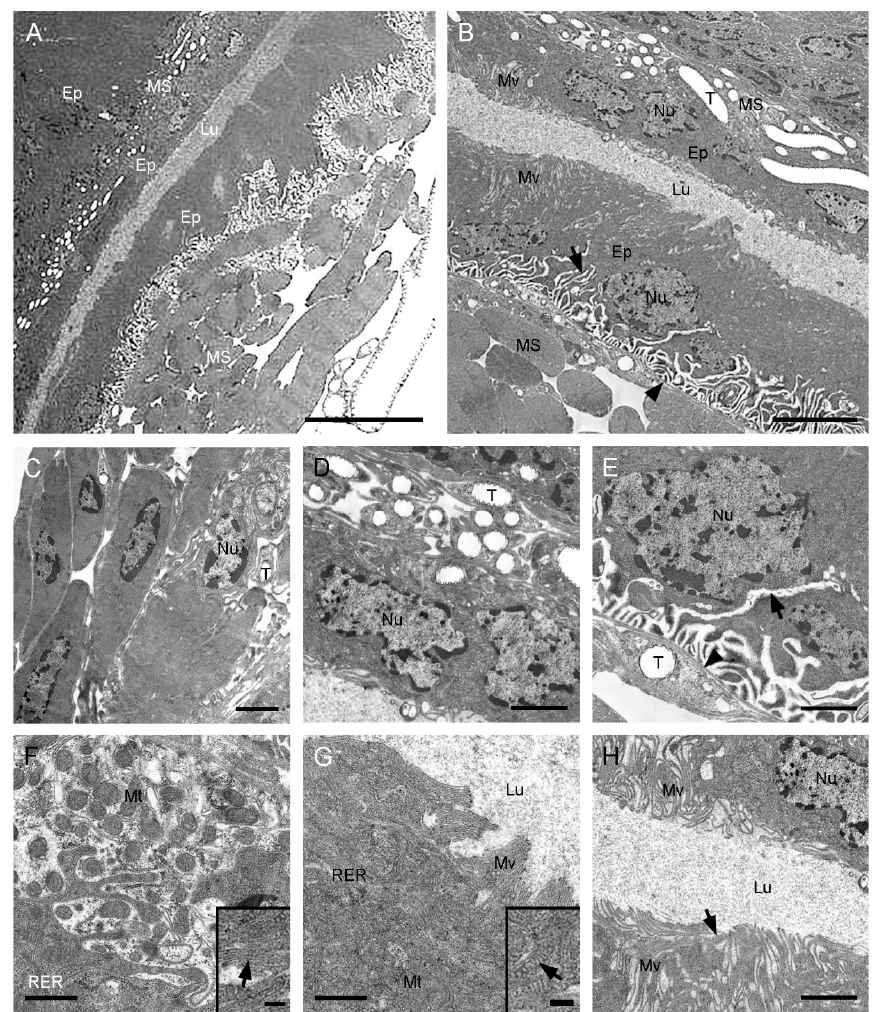
Figure 4. Accessory sac of the ejaculatory duct of Cerapanorpa nanwutaina , cross-sections, TEM. ( A ) Muscular layers sur- round the epithelium. ( B ) Two epithelia surround the lumen. Arrow points to the basal plasma membrane. Arrowhead points to the basal lamina. ( C ) Nuclei of muscle cell. ( D ) Nuclei of the inner side of epithelium. ( E ) Nuclei of the outside of epithelium. ( F ) Organelles in medial cytoplasm. Inset shows the magnification of rough endoplasmic reticulum (arrow). ( G ) Apical region of the epithelium. Inset shows the magnification of mitochondrion (arrow). ( H ) Secretions in lumen. Arrow shows the granule in intracellular space. Ep, epithelium; Lu, lumen; MS, muscular sheath; Mt, mitochondrion; Mv, microvillus; Nu, nucleus; RER, rough endoplasmic reticulum; T, tracheole. Scale bars: (A) = 10 μ m; (B) = 5 μ m; (C–E,H) = 2 μ m; (F,G) = 1 μ m; insets = 0.25 μ m.